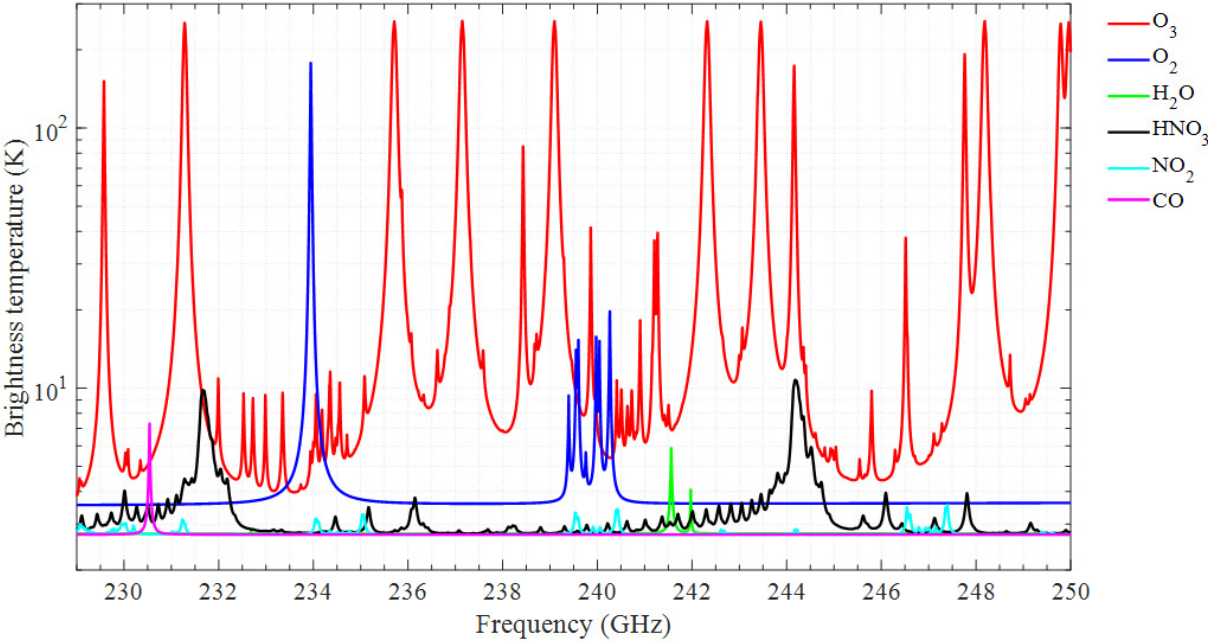
Figure 2. The contributions of the main chemical species to the brightness temperature spectrum of near the 240-GHz band at the tangent height of 30